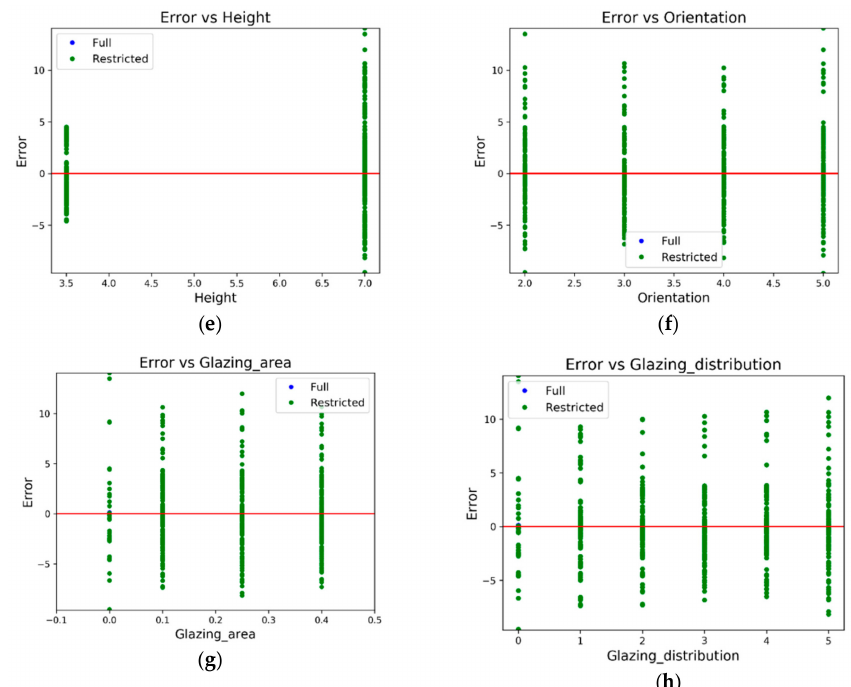
Figure 16. Errors over independent variables for the cooling problem including all the variables. ( a ) Relative compactness; ( b ) Surface area; ( c ) Wall area; ( d ) Roof area; ( e ) Overall height; ( f ) Orientation; ( g ) Glazing area; ( h ) Glazing area distribution.